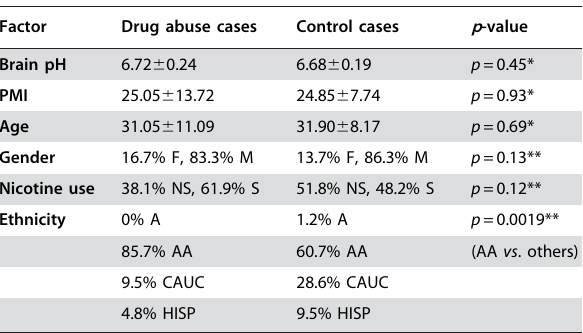
Table 1. Summary of the demographic information for